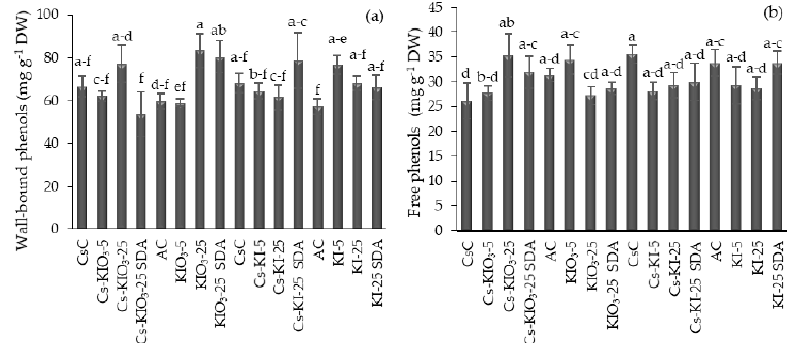
Figure 2. ( a ) Content of cell wall-bound phenols. ( b ) Content of free phenols measured in dry lettuce samples. Means with the same letter are statistically identical (LSD, p ≤ 0.05); the bars represent the